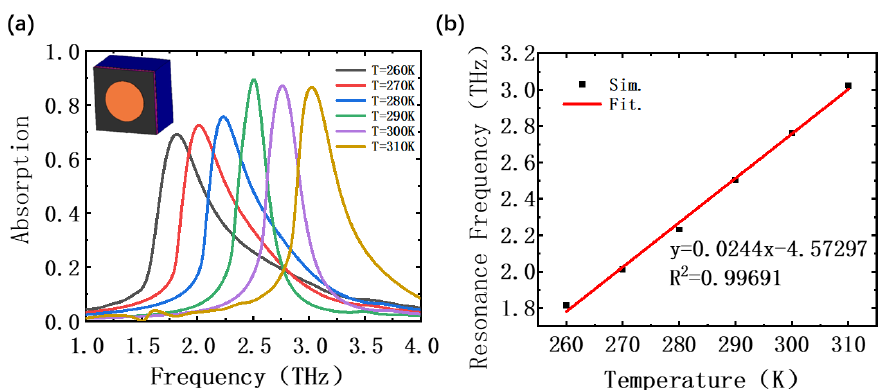
Figure 9. ( a ) Absorbance spectra of the designed PMMA based on added graphene layer with different temperature T, ( b ) the simulated resonance frequencies (black squares), and the fitting curve (solid red line) as a function of external temperature T.